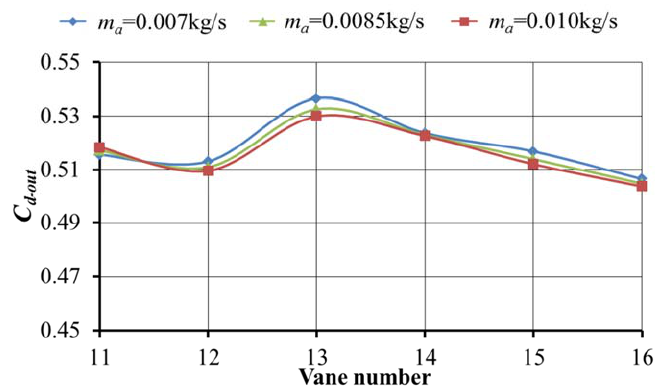
Figure 10. The effect of vane number on discharge coefficient of convergent outlet.